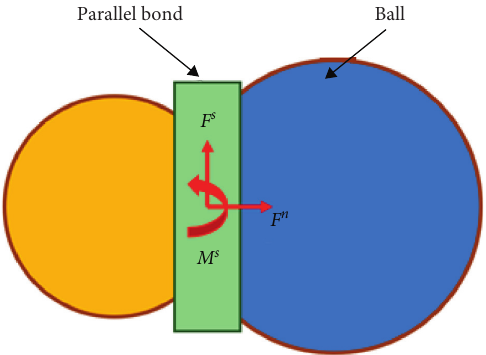
Figure 9: Schematic of parallel-bond model.